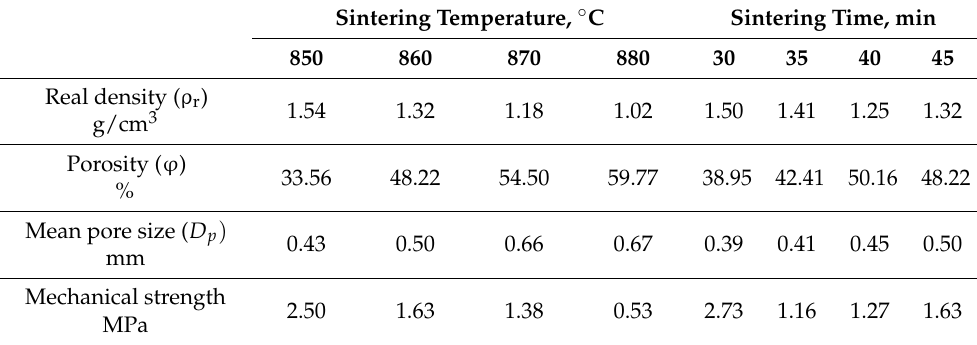
Figure 7. Cross-sectional cuts of ceramic foams produced in the absence of foaming agent and at different sintering times and temperatures. Table 7. Characteristics of the obtained foams in the absence of sodium silicate foaming agent.